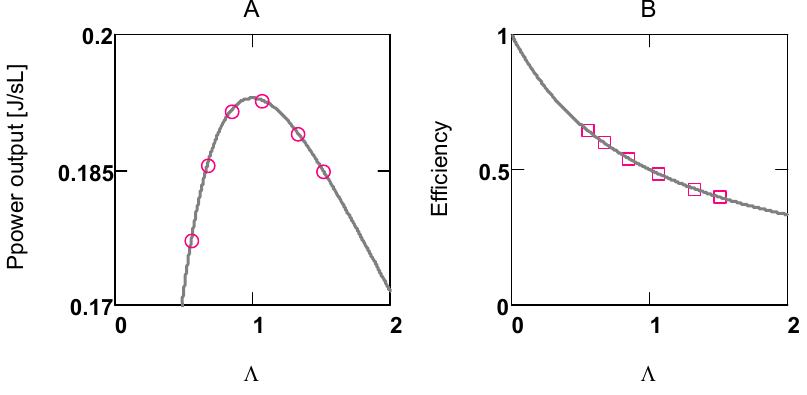
Figure 8. Power output and efficiency, respectively, versus conductance ratio A: (red circles) results from a simulation with constant conductances, (line) analytical curve according to Equation (10g); B: (red squares) results from simulation, (line) analytical curve according to Equation (10h); SIM GLY